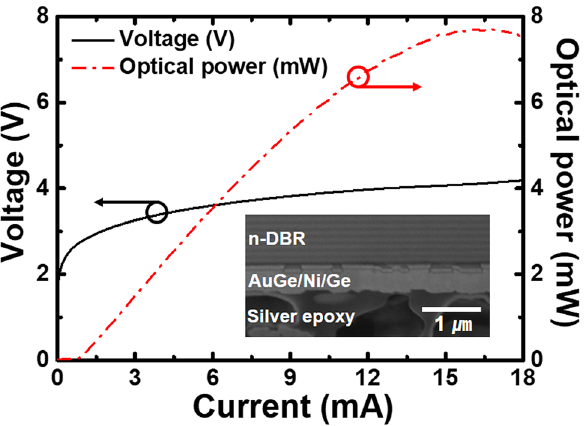
Figure 5. L–I–V characteristics of the top-emitting 940-nm thin-film VCSELs. The red lines (dash dot) are the optical power in the right y-axis, and the black lines are voltage in the left y-axis. The threshold current and voltage of the fabricated top-emitting 940 nm thin-film VCSELs are 1 mA and 2.8 V, respectively. The peak power of fabricated thin-film VCSELs is 7.7 mW at rollover current of 16.1 mA. The deformed area of n-ohmic contact layers in the SEM image could contribute to the increase in threshold voltage and steeper upward tilt to the slope of the I–V curve.